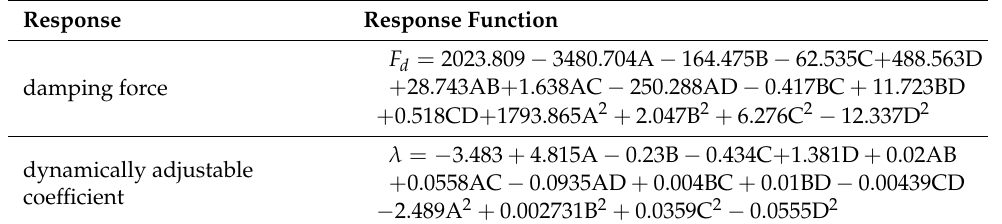
Table 5. Mathematical model of response